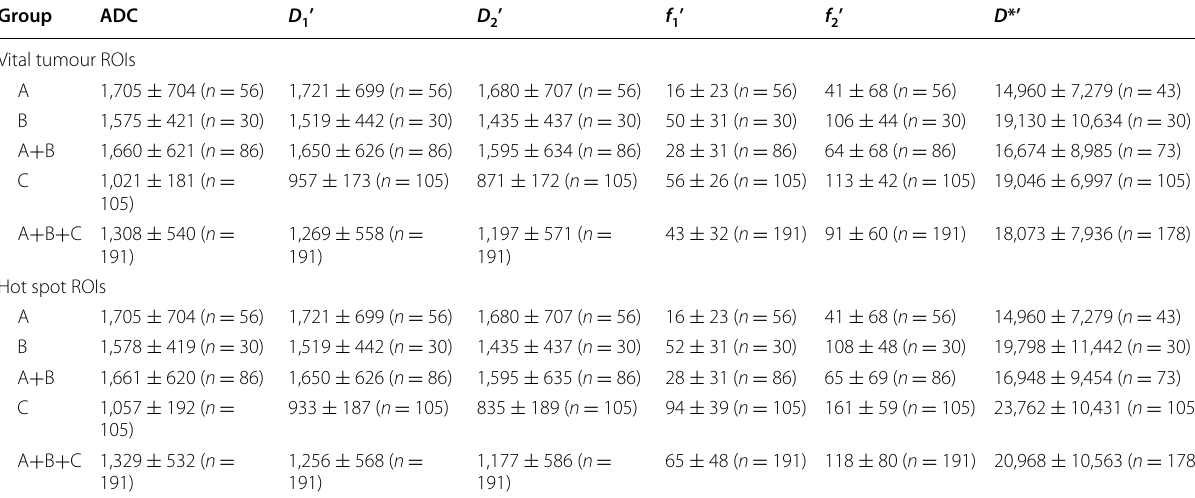
Table 3 Apparent diffusion coefficient (ADC) and intravoxel incoherent motion parameter values for benign lesions with hyperintensity on DWI with b 800 s/mm 2 and no or non-suspicious contrast-enhancement (group A, n = suspicious contrast-enhancement (group B, n 30) and malignant lesions, which were all with suspicious contrast-enhancement = (group C, n 105) =